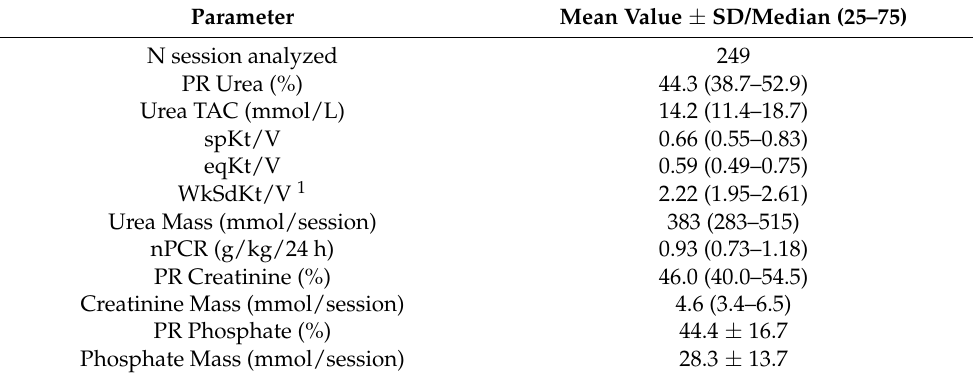
Table 4. Clinical performances of the Physidia S 3 daily home dialysis monitor. (PR, percent reduction; TAC, time average concentration; sp, single pool; eq, equilibrated; WkSd, weekly standardized; nPCR, normalized protein catabolic rate). Values were described by using mean values ± standard deviation or median (percentile 25–percentile 75) according to their